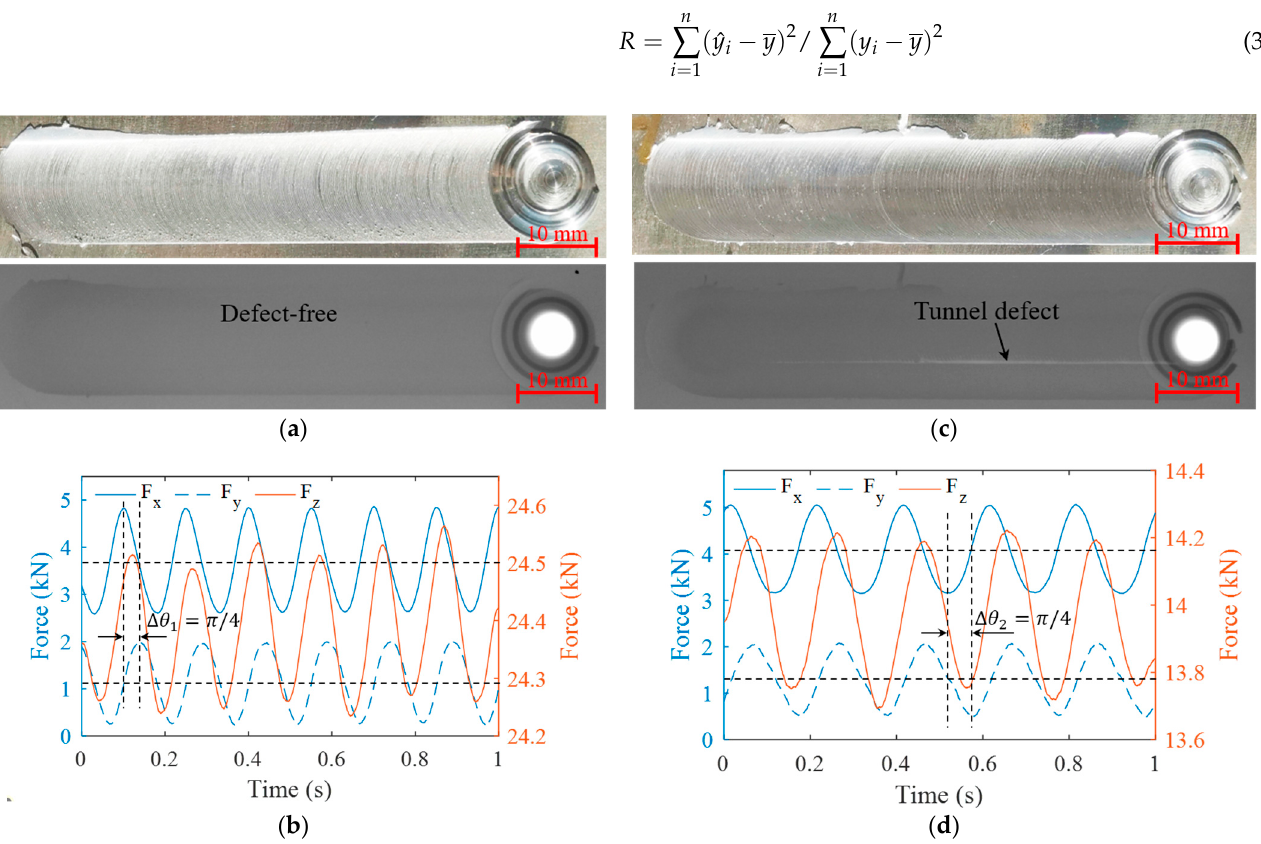
Figure 6. Experimental results under different welding processes: ( a ) weld morphology; ( b ) three- dimensional forces with rotational speed of 400 rpm and welding speed of 200 mm/min; ( c ) weld morphology; ( d ) three-dimensional forces with rotational speed of 300 rpm and welding speed of 120 mm/min. Table 2. The fit results of three-dimensional force with rotational speed of 400 rpm and welding speed of 200